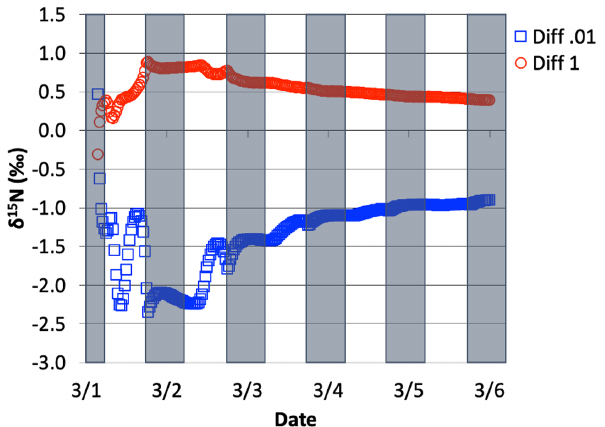
Figure 14. The difference in δ 15 N(HNO 3 ) values when the isotopic effect during N 2 O 5 heterogeneous reactions is included and when it = 0 . 1, relative to 0.01 and is excluded, for the simulation of k N 2 O 5 1.0. The 5d simulation was under the conditions list in Table S3e.